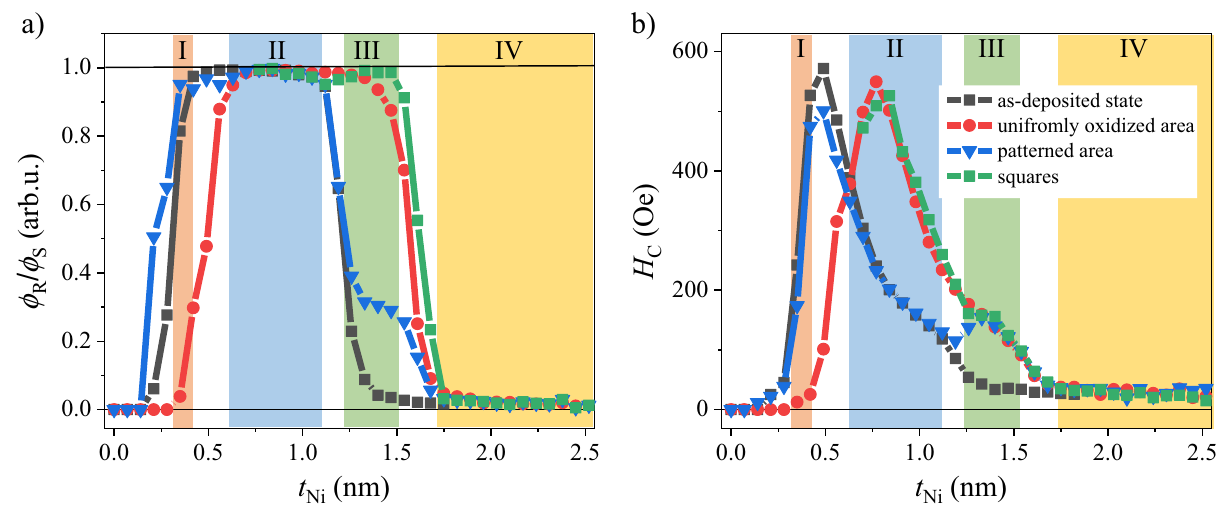
Figure 5. Changes of magnetic properties determined from P-MOKE hysteresis loops registered for three different areas: sample before PO, after uniform PO, and local PO: ( a ) the ratio of remanence to saturation ( ϕ R / ϕ S ) of P-MOKE signal as a function of Ni thickness ( t Ni ). Numbers of particular t Ni regions corresponds to different magnetic states of the matrix and the squares, respectively: (I) PMA and almost non-ferromagnetic state; (II) PMA and PMA, both with significantly different coercivity; (III) IMA (in-plane magnetic anisotropy) and PMA; (IV) IMA and IMA with different saturation fields; ( b ) coercivity field ( H C ) versus thickness of Ni sublayer ( t Ni ). Additionally, H C and ϕ R / ϕ S extracted for squares from P-MOKE hysteresis loops measured in patterned area are plotted in the regions II-IV (green